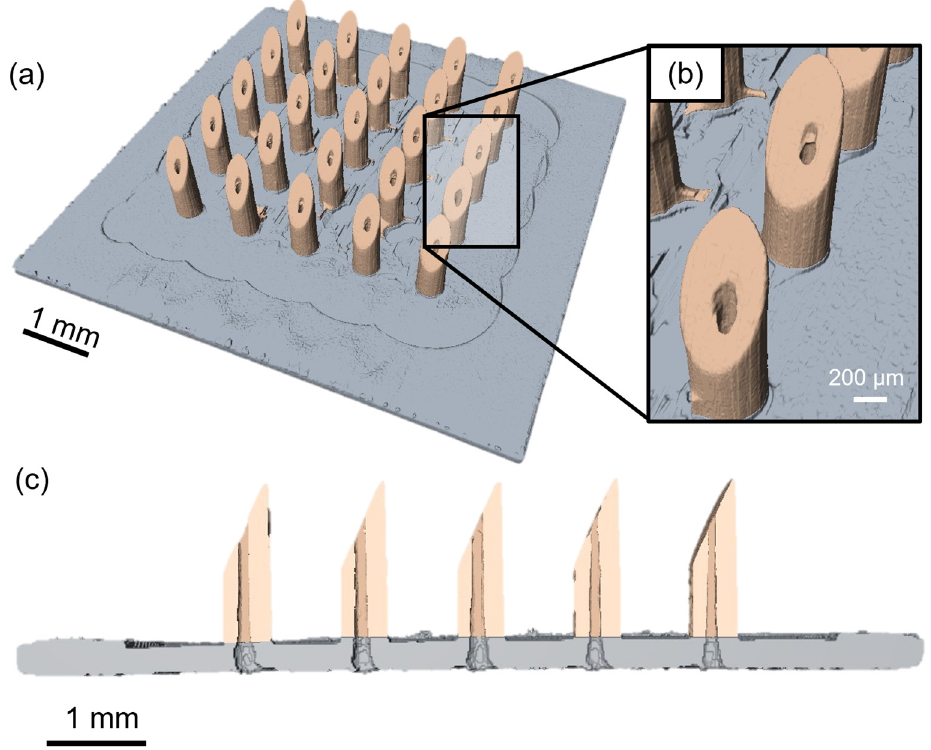
Figure 4. ( a ) Three-dimensional reconstruction of a full 5 × 5 HMNA with indicative lengths of 1647 ± 12 μ m and outer diameters of 451 ± 9 μ m. False colors (grey and orange) were added to increase the visibility of the machined features. ( b ) Close-up view of a 2 MN shafts. ( c ) Cross-sectional view of the same HMNA showing 5 open lumens and sharp tips as a result of the chosen bevel angle of 25°.